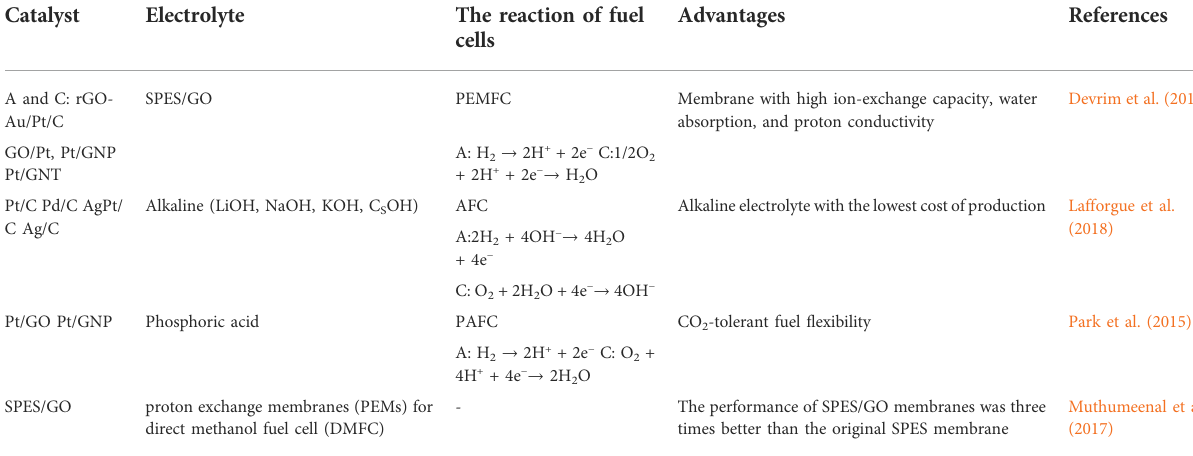
TABLE 2 Catalytic reactions involved in the energy production through the fuel cell. Catalyst Electrolyte The reaction of fuel cells